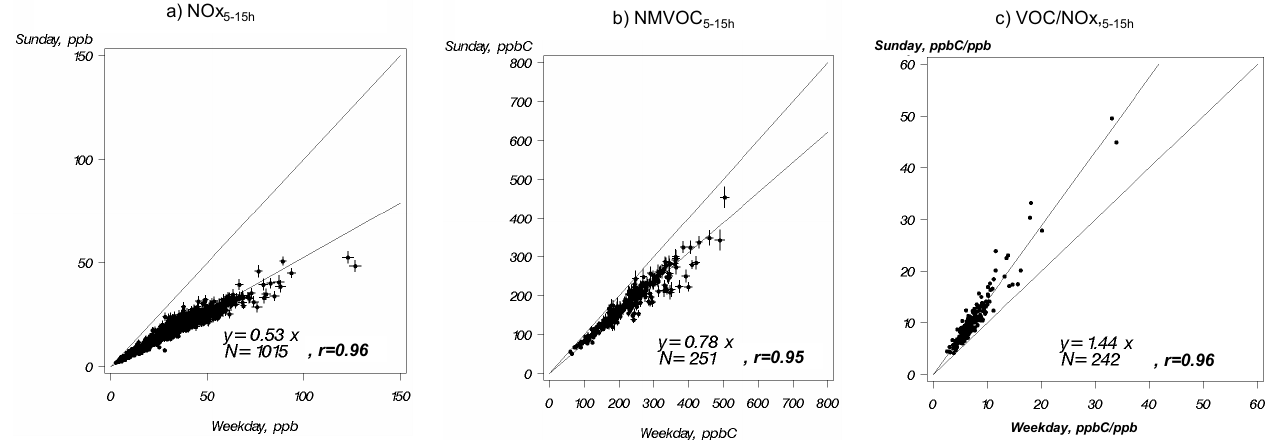
Fig. 1. Comparison of precursor concentrations between weekdays and Sundays measured from 05:00 to 15:0LT during 1999–2004. Bars in (a) and (b) indicate the 95% confidence limits of the mean